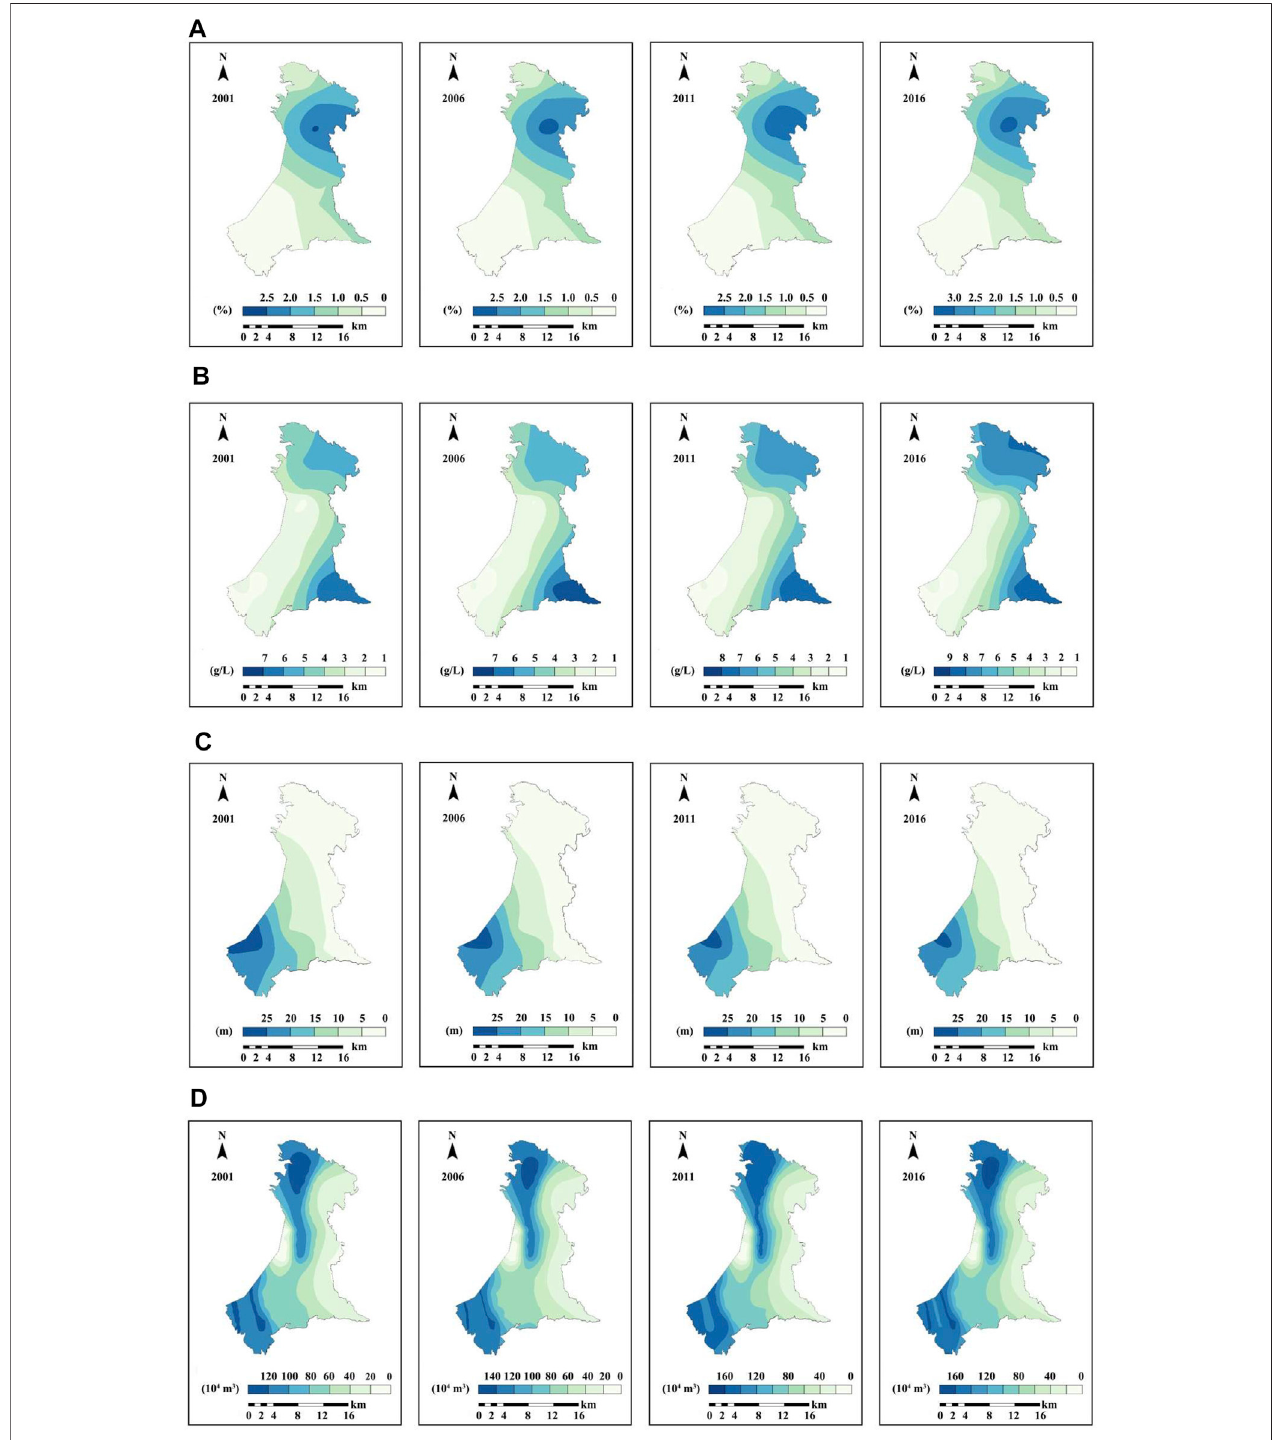
FIGURE3| Spatialinterpolationdiagramofeachelementindifferentyears[ (A) soilsaltcontent(unit:%); (B) groundwatermineralization(unit:g/L); (C) groundwater buried depth (unit: m); (D) surface irrigated water amount (unit: 10 4 m 3 )]